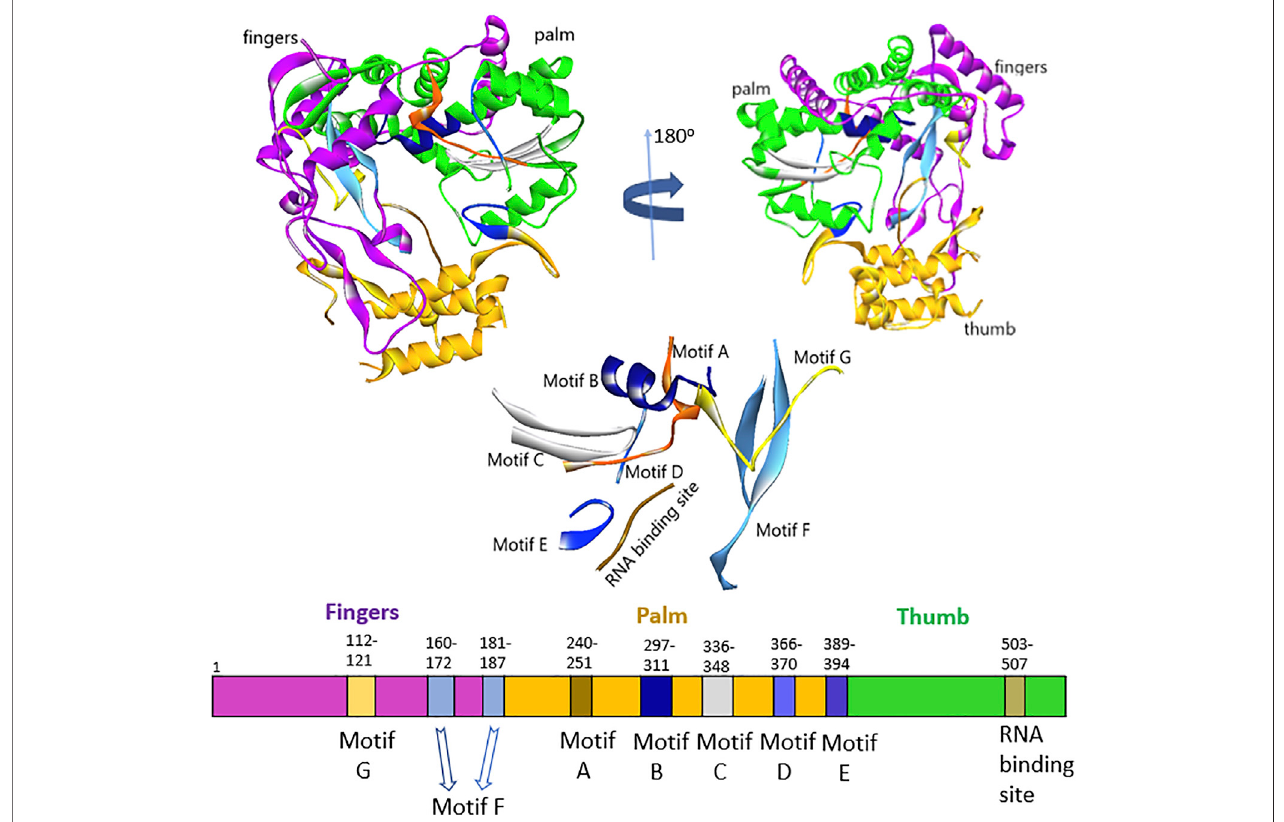
FIGURE 1 | Representation of fi ngers, palm, and thumb domains, including seven motifs (A – G) HuNoV RdRp.